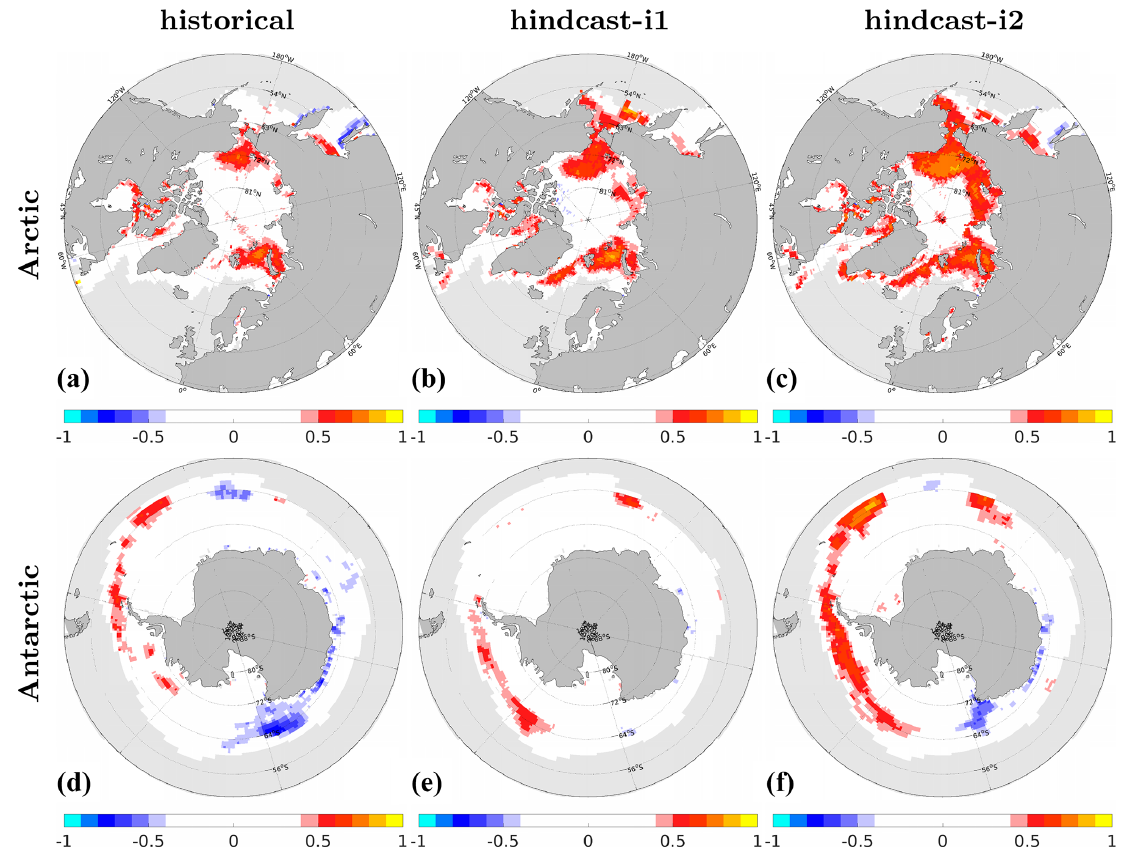
Figure 16. ACC for sea ice concentration (SIC) for historical (a, d) , hindcast-i1 (b, e) and hindcast-i2 (c, f) in the Arctic (a, b, c) and Antarctic (d, e, f) for LY1. Observations are from HadISST1 (Rayner et al., 2003) over the period 1960–2018. The data are interpolated to a regular 1 ◦ × 1 ◦